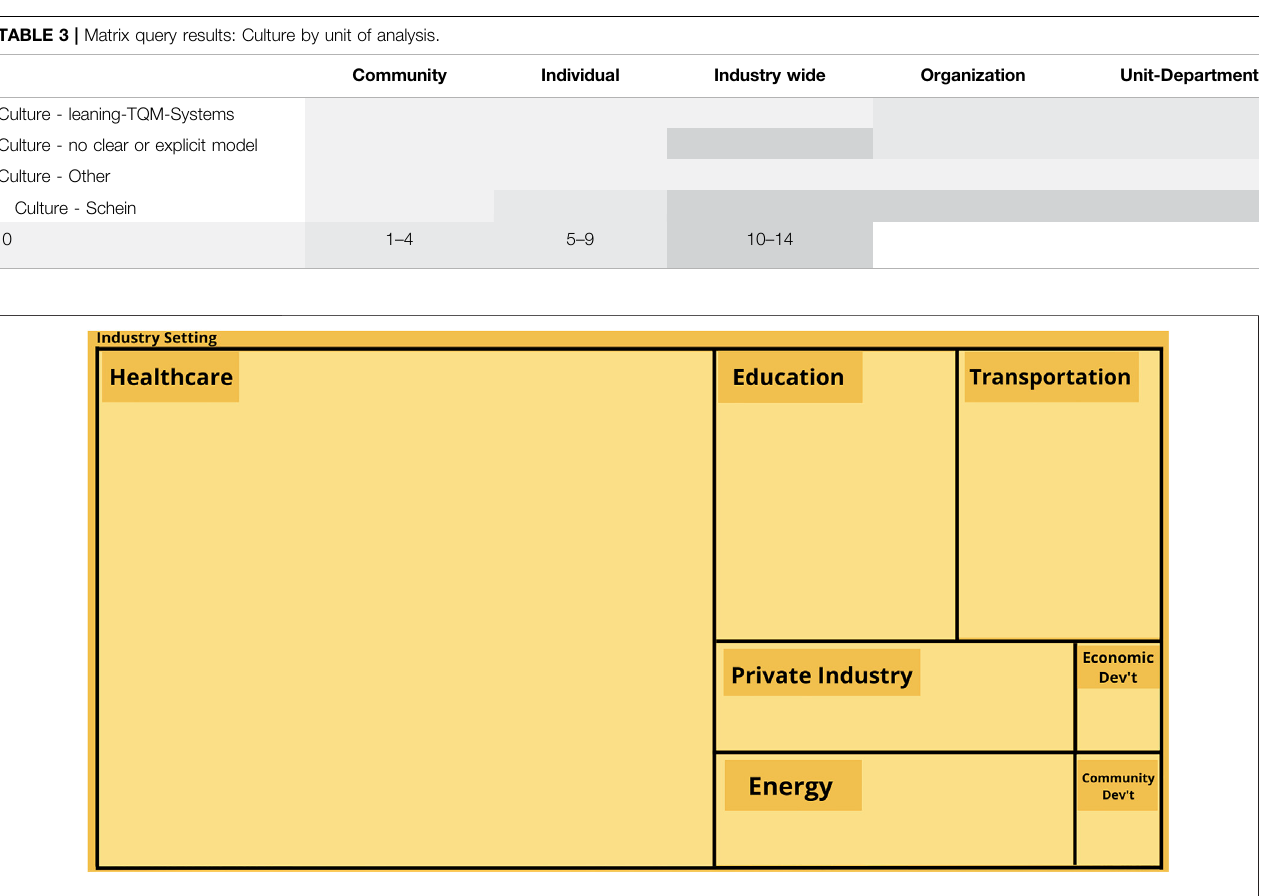
FIGURE 4 | Industry node tree map.